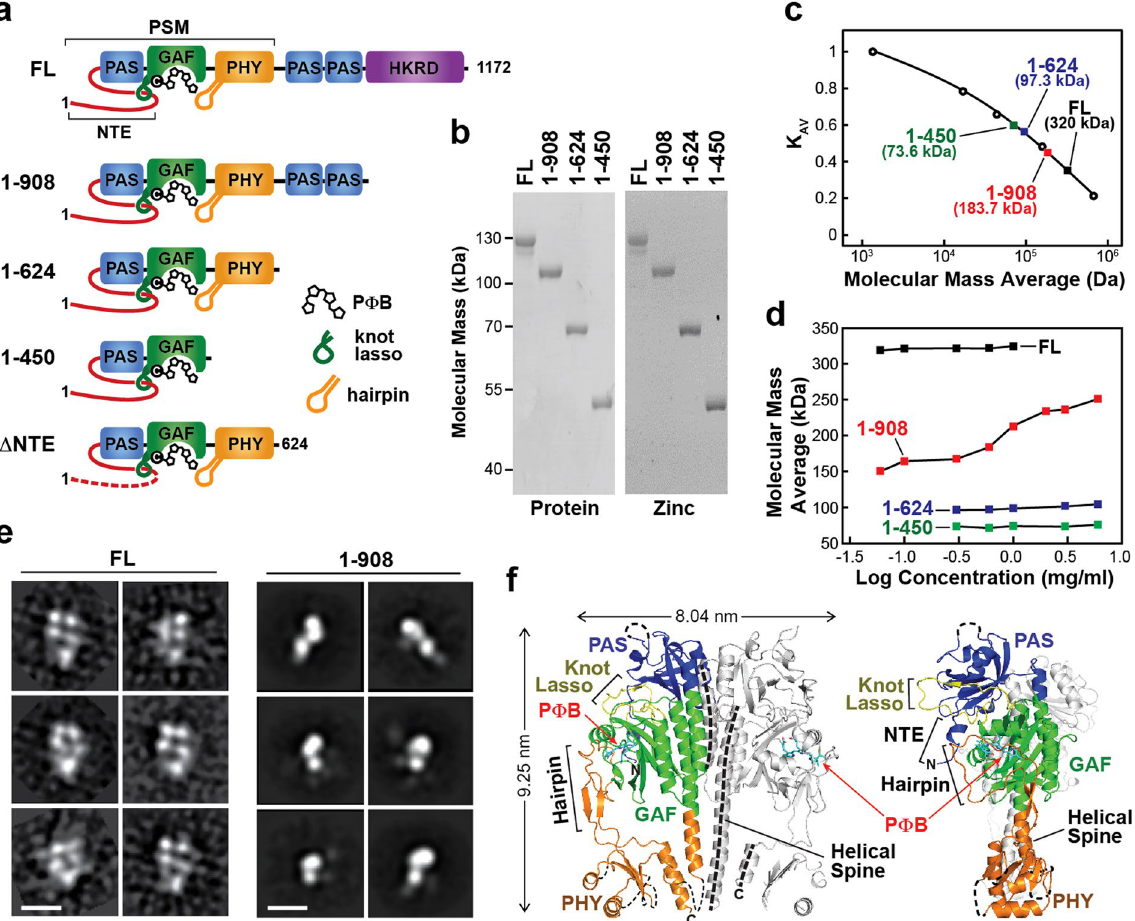
Figure 1. The OPM is required for oligomeric assembly of PhyB. (a) Domain organization of Arabidopsis PhyB and composition of the truncation mutants used in this study. The numbers of the N- and C-terminal residues are indicated. PAS, GAF, PHY and HKRD segments are labeled. The bilin, figure-of-eight knot, and hairpin features are indicated. C represents the cysteine that covalently binds P Φ B. (b) Assembly of the samples with P Φ B. Preparations were subjected to SDS-PAGE and either stained for protein with Coomassie Blue or for the bound bilin by zinc-induced fluorescence. For full-length images of the SDS-PAGE gels see Supplementary Fig. S1. (c) Quaternary mass of FL PhyB and truncations as determined by SEC of the preparations at 0.6 mg/ ml concentration. The calculated masses based on a suite of size standards are indicated. K AV = (V e − V 0 ) ⋅ (V t − 1 , where K − V 0 ) AV is the molecular partition function, V e is the elution volume, V 0 is the void volume as measured by blue dextran, and V t is the volume accessible to solvent as measured by vitamin B 12 . (d) The size dependence of FL PhyB and the truncations on chromoprotein concentration. (e) Single-particle EM images of FL PhyB and the 1–908 truncation generated after negative staining. Selected reference-free class averages assembled from the electron micrographs are shown. The scale bar indicates 10 nm. (f) Orthogonal ribbon views of the crystal structure of dimeric PhyB(90–624) fragment (PDB: 4OUR) for comparison to the EM images in panel (e). The molecular dimensions of the model are indicated. The PAS, GAF, and PHY domains are colored in blue, green and orange, respectively. P Φ B is in cyan. The helical spine, hairpin, knot lasso, and NTE features are highlighted. N, N-terminus. C,